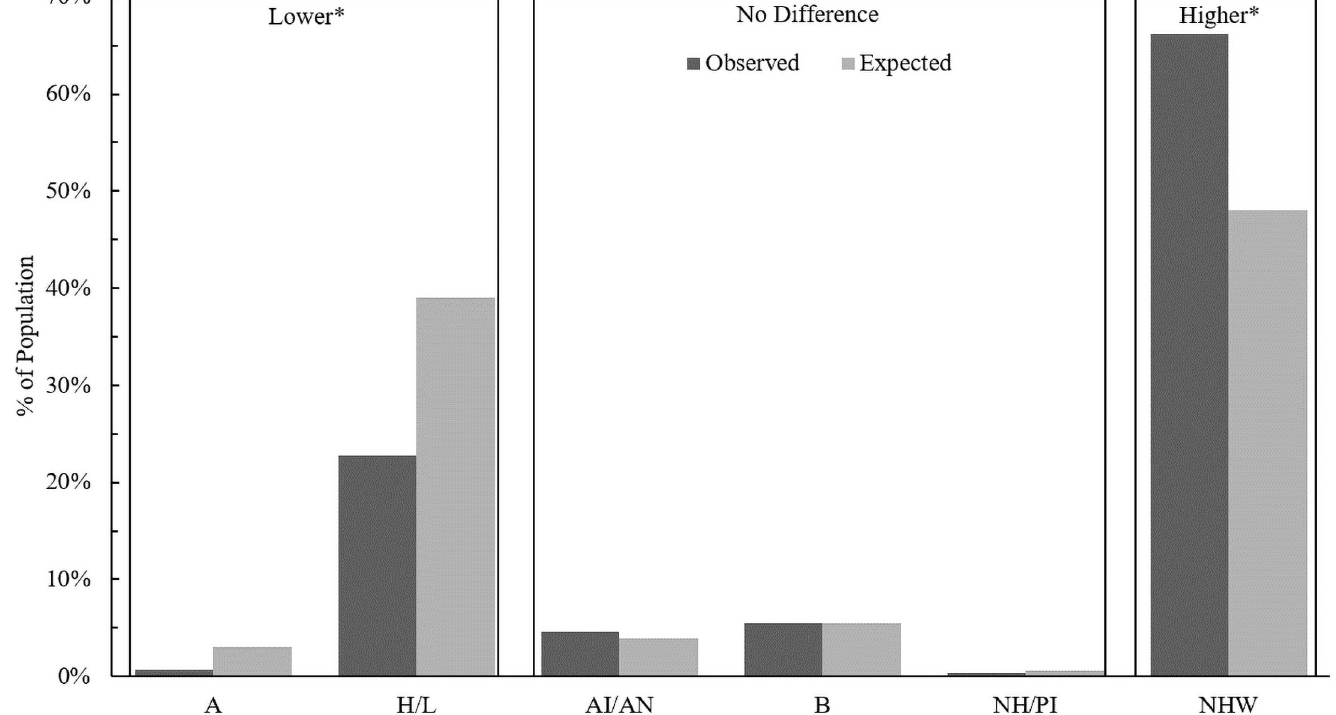
Fig 3. Comparison of the observed versus expected proportions of opioid dependence at the time of giving birth in each racial/ethnic group of mothers. Boxes labelled higher or lower mean that the observed proportions are significantly higher or lower than the expected proportion after post-hoc comparisons that incorporate a Bonferroni correction with six groups (p < 0.001/6). A: Asian, H/L: Hispanic or Latino, AI/AN: American Indian or Alaskan Native, B: Black, NH/PI: Native Hawaiian or Pacific Islander, NHW: Non-Hispanic White.